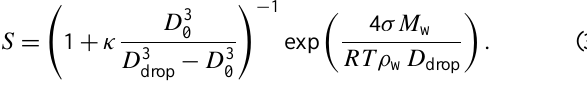
data scattering tends to decrease as the supersaturation in- creases and the overestimation tends to be higher as the parti- cle size decreases. The mean relation between simulated and observed N CCN was 1.44 ± 0.48 for 0.23 % supersaturation and 1.91 ± 0.40 for 1.13 % supersaturation. A lower error